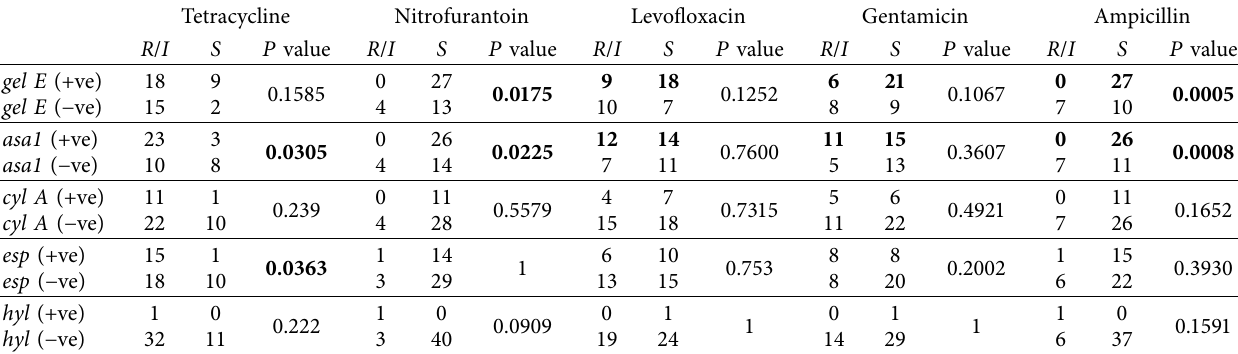
Table 3: Association of resistance to antibiotics and virulence factors.